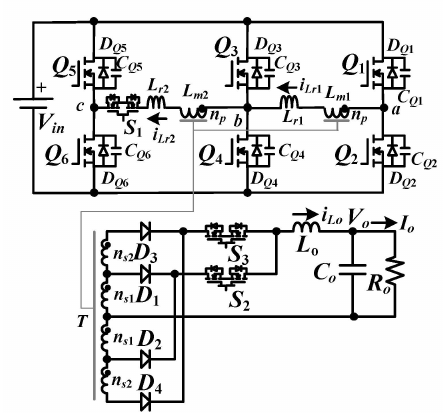
Figure 1. Circuit structure of the developed converter.